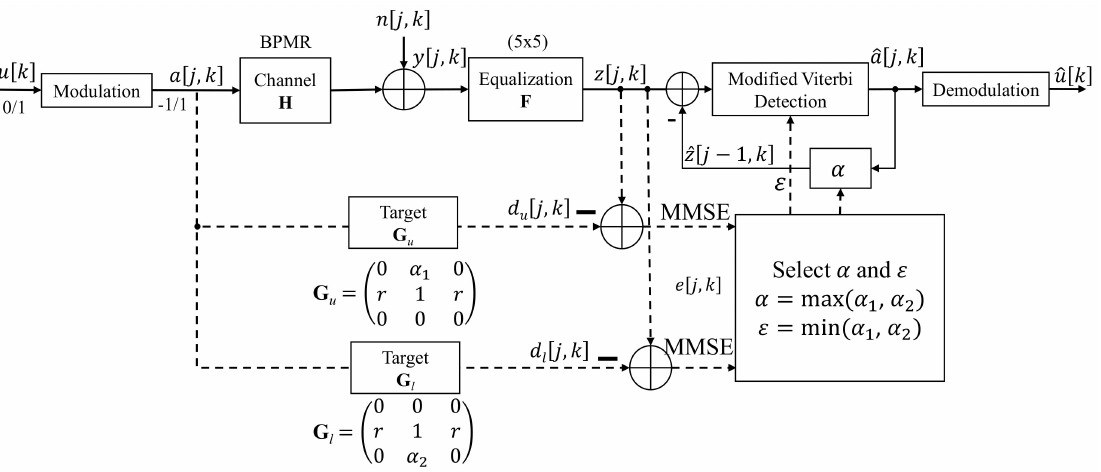
Figure 7. The proposed system